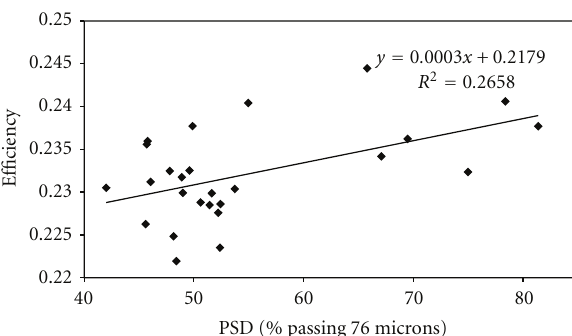
Figure 2: Negligible correlation between PSD and e ffi ciency. impacted bottom ash values. This may explain why bottom ash carbon values are significantly higher than fly ash carbon values in Table 3 for some tests.